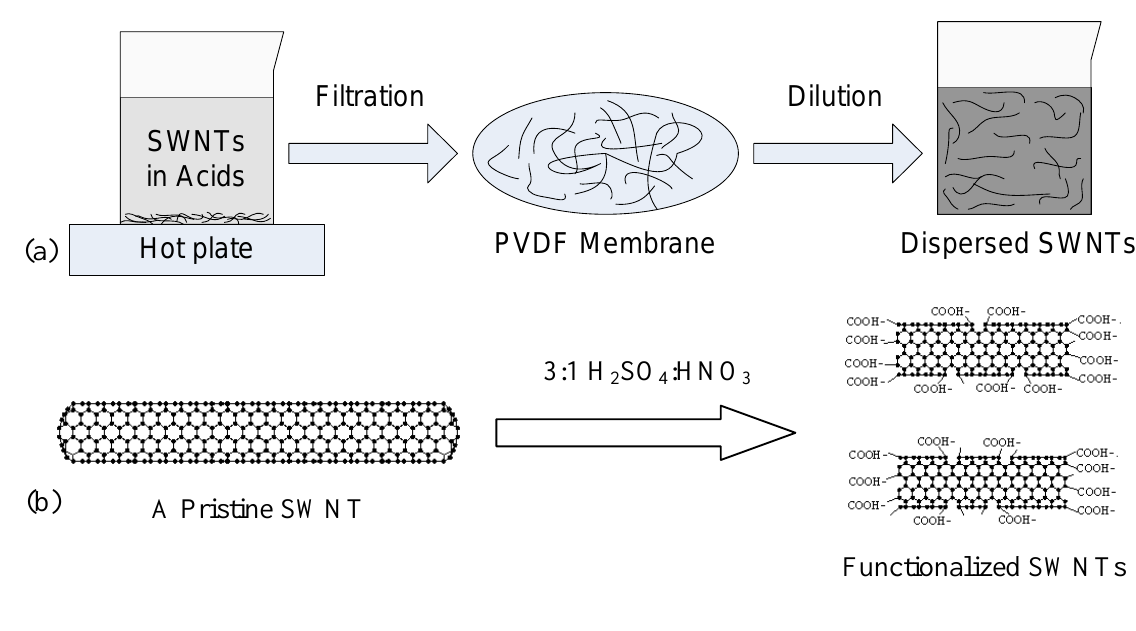
Figure 1. (a) Surface functionalization process of SWNTs with acid treatment, filtration and dilution. (b) Scheme of the chemical functionalization of a